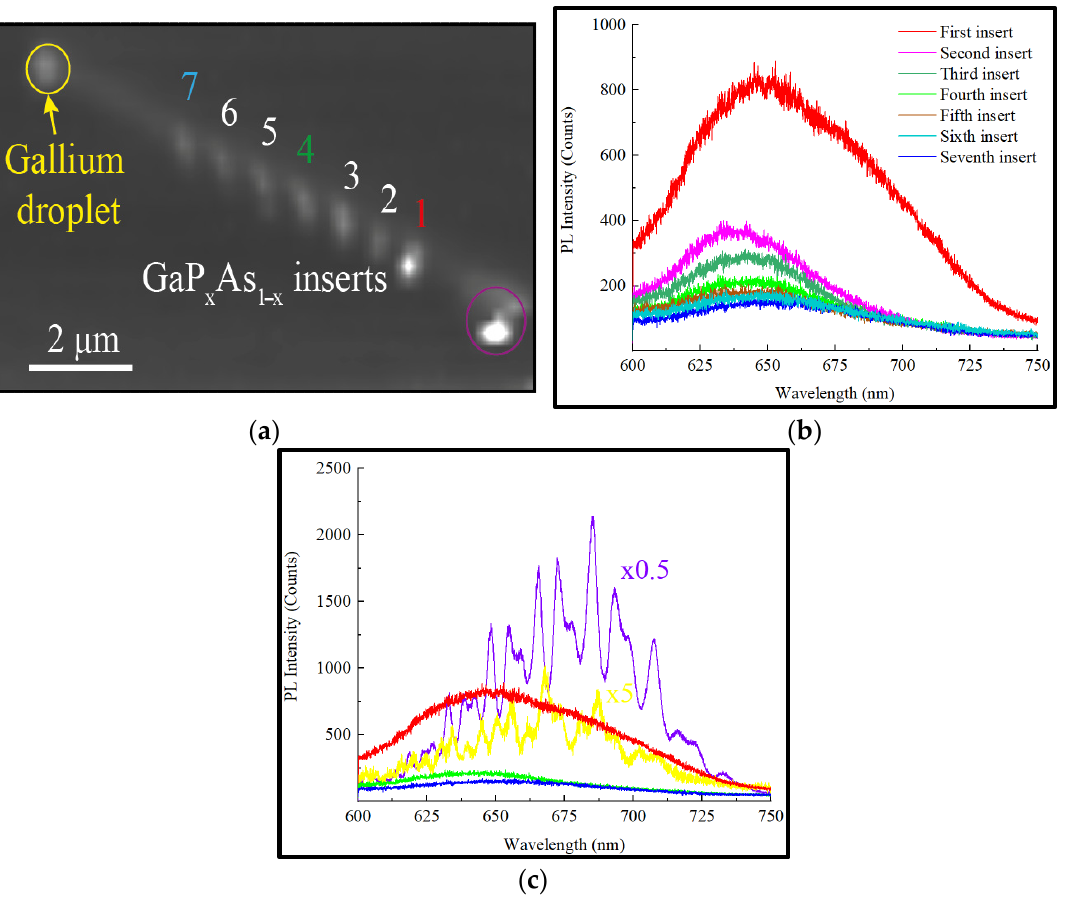
Figure 3. ( a ) RT PL integral intensity map of the studied NW, and ( b ) PL spectra acquired at each of the GaPAs NDs. ( c ) PL spectra measured on the edge side without the Ga droplet (violet, multiplied by 0.5 for visibility); on the edge with the Ga droplet (yellow, multiplied by 5); and at the NDs 1 (red), 4 (green) and 7 (blue).